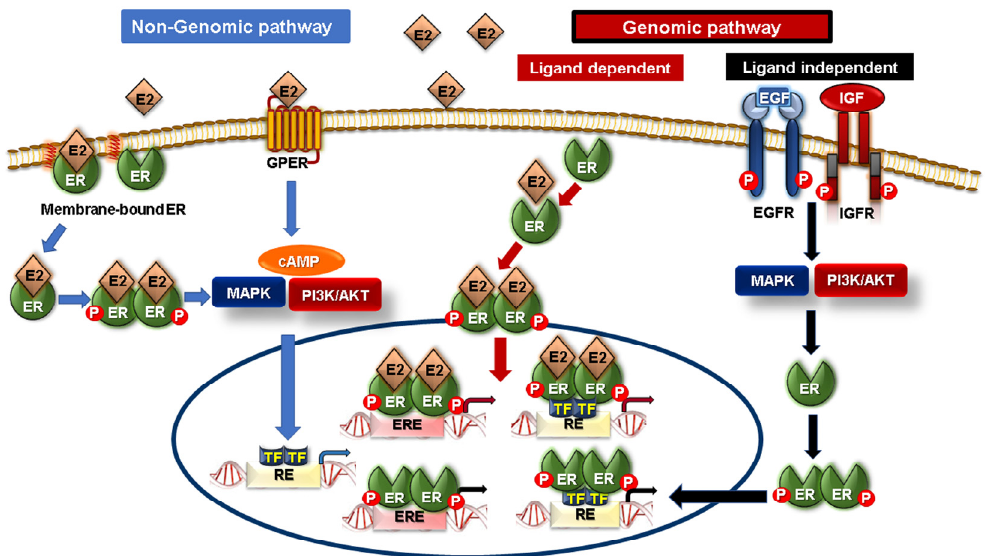
Figure 1. Estrogen receptor (ER) signaling pathway. Two signaling pathways are known to mediate ER signaling, including genomic (ligand-dependent and -independent) and non-genomic pathways. In ligand-dependent genomic pathways, estradiol (E2) can bind to ER to induce transcription of estrogen response element (ERE) genes. In ligand-independent genomic pathways, phosphorylation of ER is mediated by EGF/EGFR or IGF/IGFR-induced PI3K/AKT and MAPK activation. On the other hand, the non-genomic pathway is regulated by membrane-bound ER or G-protein coupled ER (GPER), whereby binding to E2 leads to activation of PI3K/AKT and MAPK signaling. Moreover, several studies have reported that E2-ER signaling has a modulatory im- pact on SDC expression not only in ER α -positive but also in ER α -negative breast cancer cells (Figure 2) [96]. E2-ER signaling induces SDC2 expression while repressing SDC4 expression in both ER α -positive and -negative breast cancer cells. Mechanistically, the E2 effect on SDC expression is mediated through the interplay between ERs, EGFR, and/or IGFR. In ER α -positive cells, EGFR is a critical mediator of the E2 inhibitory impact on SDC4 expression. However, EGFR has an opposing influence on E2-induced SDC2 expression. In ER β -positive cells, IGFR has a principal role in E2-induced SDC2 expression [91]. Moreover, IGFR is a key regulator of cell adhesion and invasion via the modulation of SDC4 and integrin expression at the protein level based on ER status, which is also strongly influenced by IGFR activation. This study suggested that IGFR plays a protective role against breast cancer aggressiveness by sustaining the expression of SDC4 and integrins for binding to fibronectin and laminin in ER α -expressing MCF-7 cells [91,97]. Notably, it has been